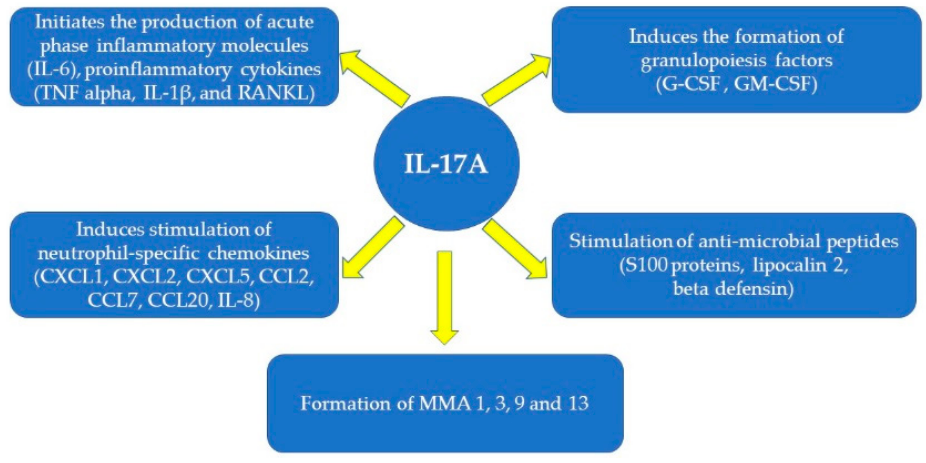
Figure 1. Roles of IL-17A.